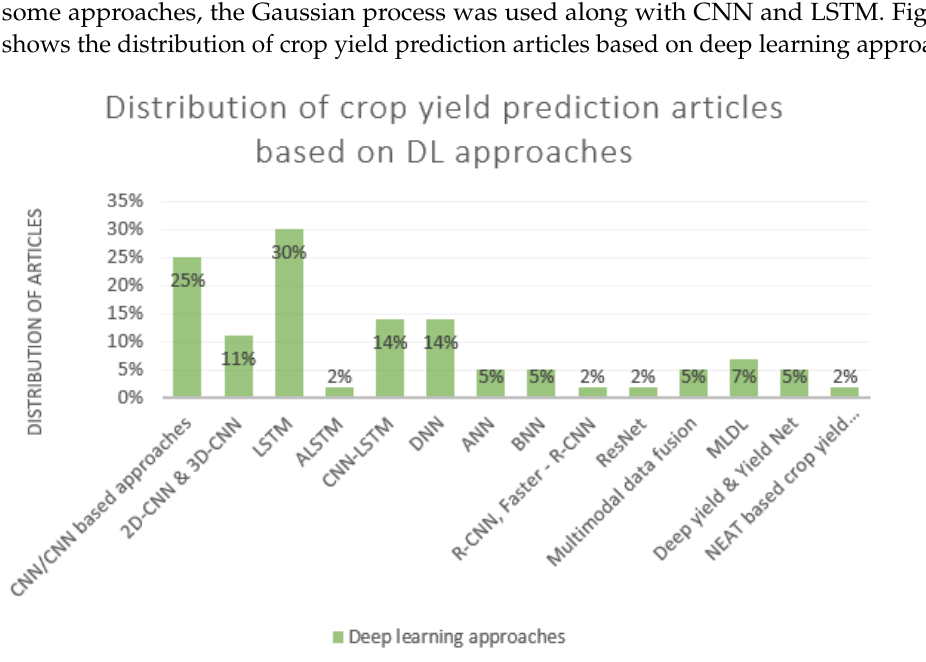
Figure 3. Distribution of articles based on deep learning approaches.